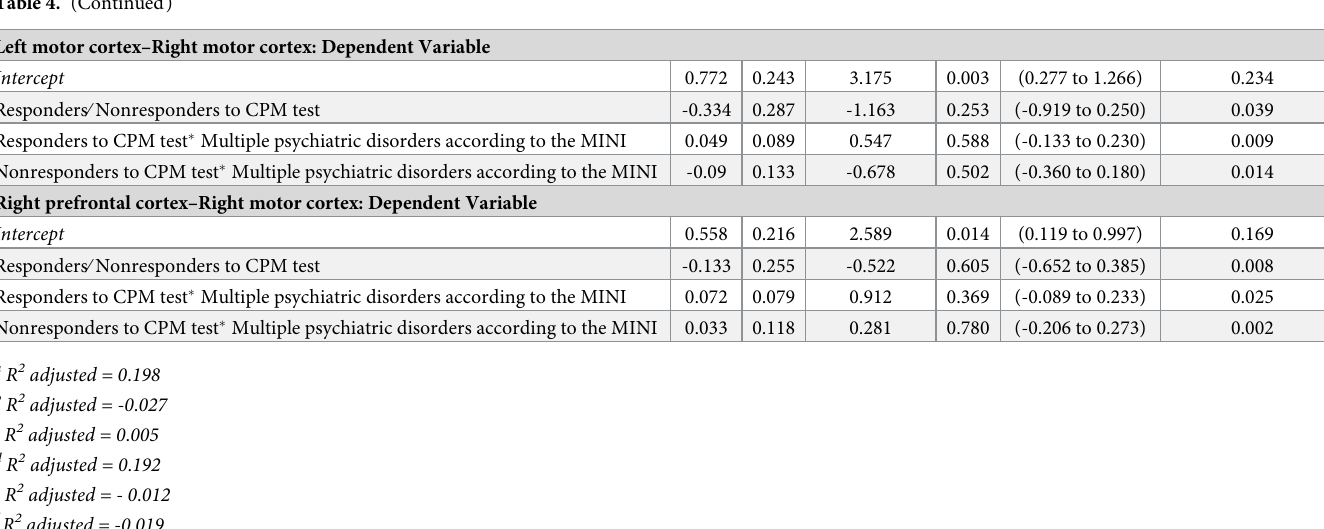
t = -2.447, p = 0.02) and in left MC − right PFC (adjusted R 2 = 0.192, standard β coefficient for the CPM-test = -0.582, t = -2.805, p =